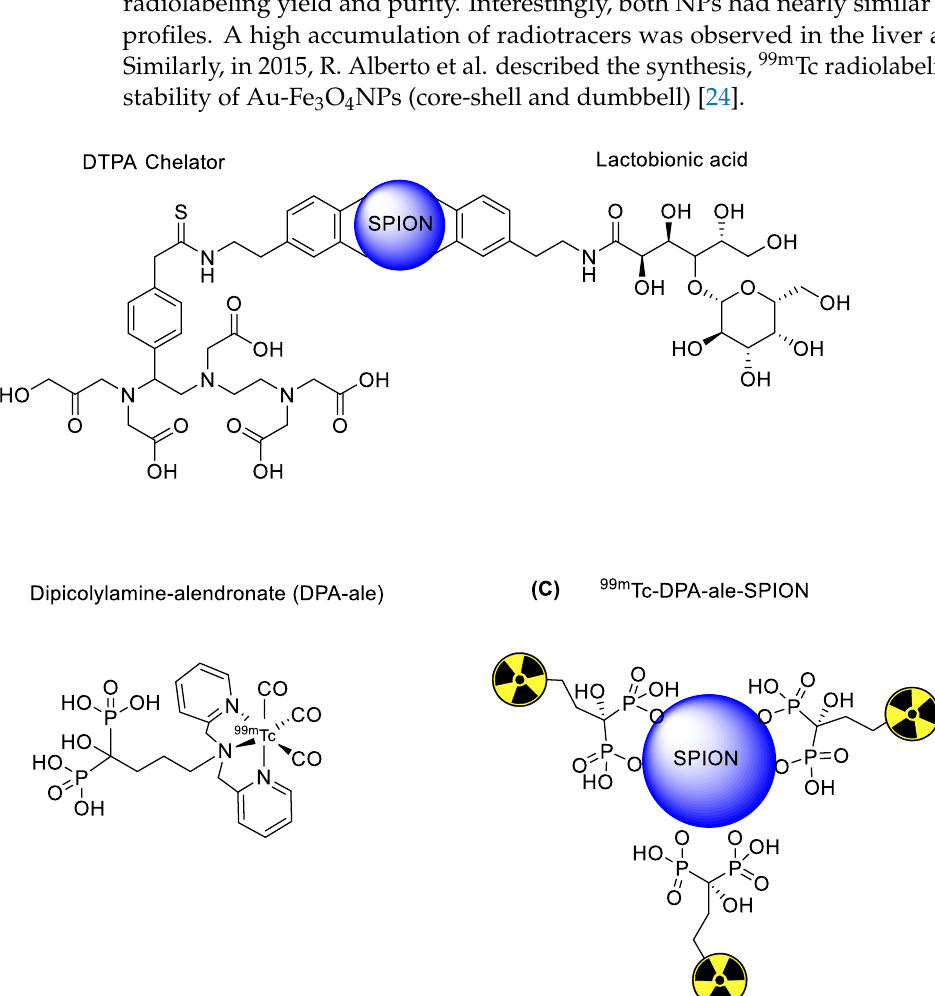
Figure 2. 99m Tc radiolabeling of various SPIONs. ( A ) Schematic of a lactobionic acid-installed SPION [28]. ( B ) 99m Tc radiolabeled DPA-ale. ( C ) 99m Tc radiolabeled DPA-ale-installed SPION [29].